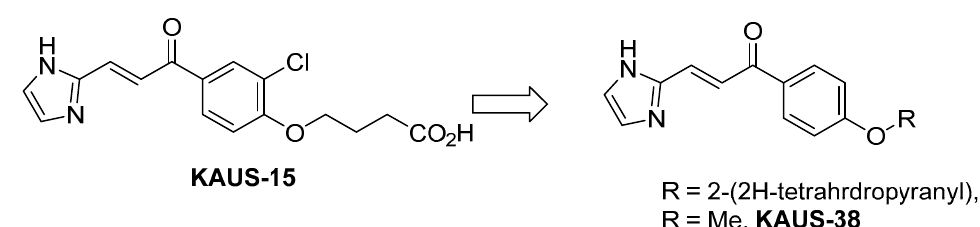
Figure 1. Earlier Hb modulators based on Michael Addition scaffold.